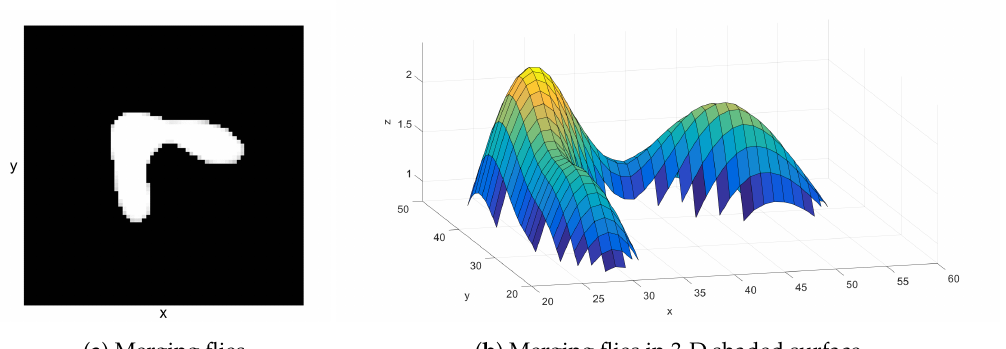
Figure 4. ( a ) Merging flies in a 2-D scene and ( b ) in a 3-D shaded surface. The merging flies appear as a single white area. By observing the merging flies in a 3-D shaded surface, this single area seems to contain two flies since there are obviously two mountains in the image.